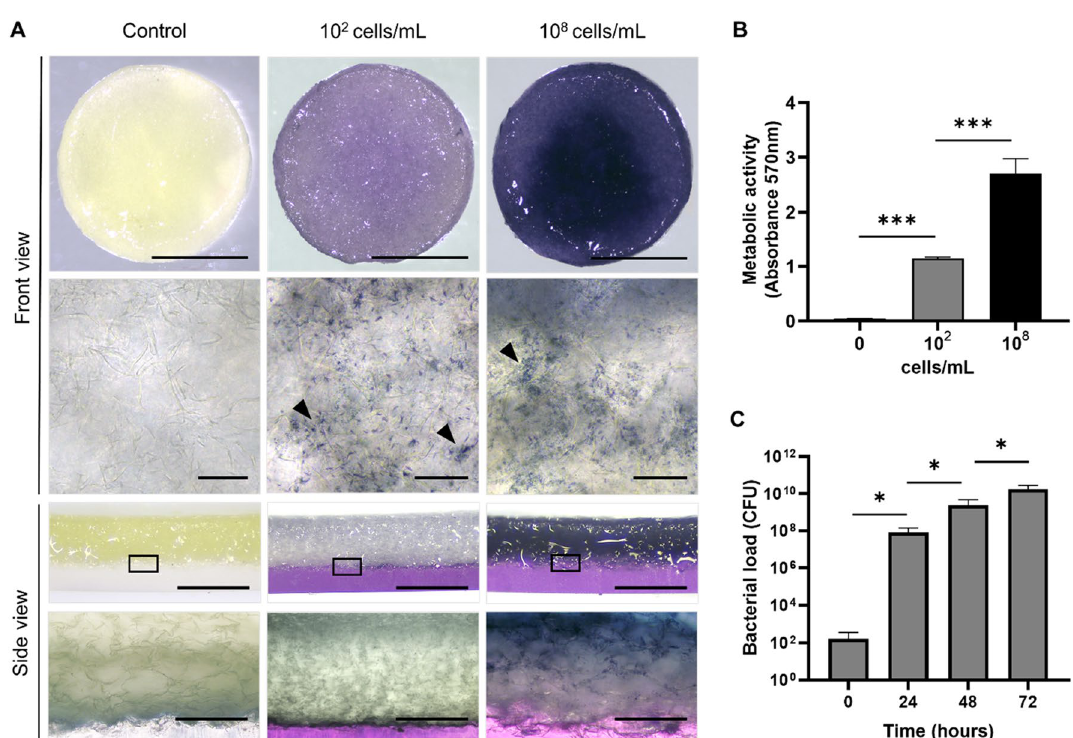
Figure 2. Viability, distribution, and bacterial loads of biofilms formed in scaffolds. ( A ) MTT assay of scaffolds seeded with 10 2 or 10 8 cells/mL or without cells (control) and incubated for 24 h showed equal distribution of viable biofilms across the scaffolds in both, front and side views. In higher magnification of scaffolds, bacterial accumulation was observed (arrow heads). ( B ) Quantitation shows that metabolic activity increased according to the initial cell density. ( C ) Biofilm-containing scaffolds were diluted and plated in TSS agar for CFU counting. Quantitation shows over 10 5 CFU/scaffold after 18 h incubation of scaffolds, and up to 10 10 CFU/scaffold after 72 h of bacterial growth. Scale bar for A represents 10 mm (front view), 50 µm (upper zoom), 0.5 mm (side view), 240 µm (lower zoom). Values plotted are mean ± SD (N = 3). One-way ANOVA and Tukey’s posterior comparison for B and unpaired t-test, comparing each time point with their previous condition for C. * p < 0.05; ***p <